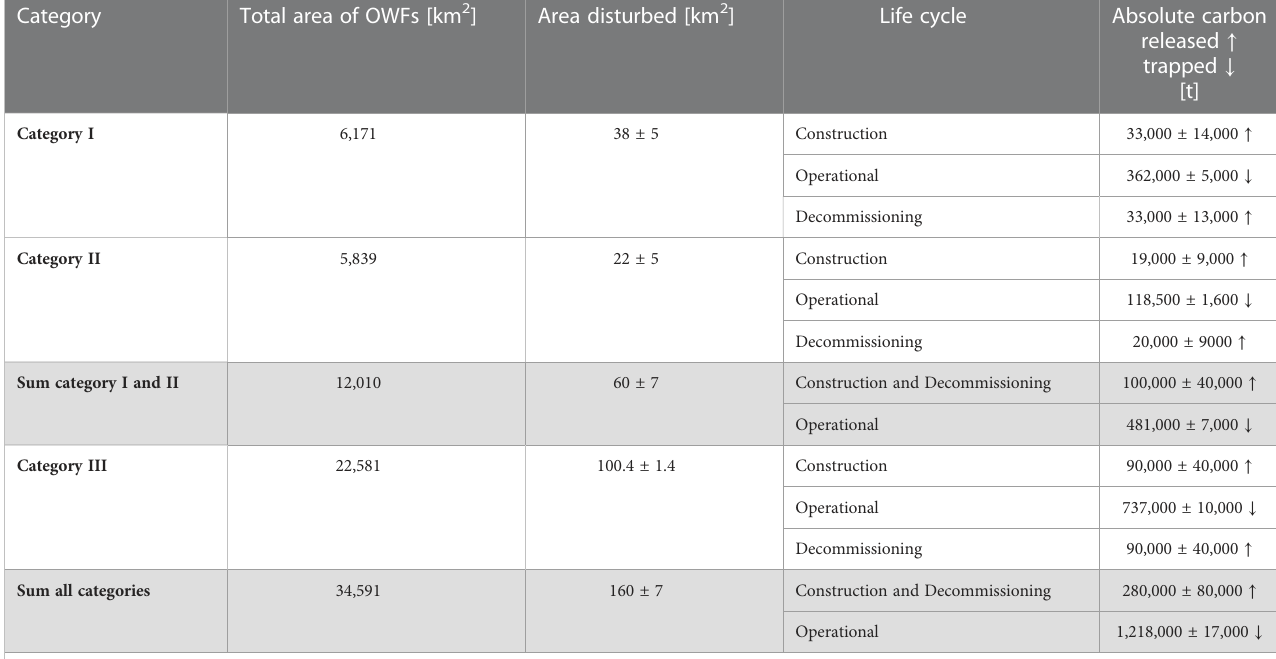
TABLE 1 Carbon released and trapped during the different phases of the life cycle of OWFs in the SNS.